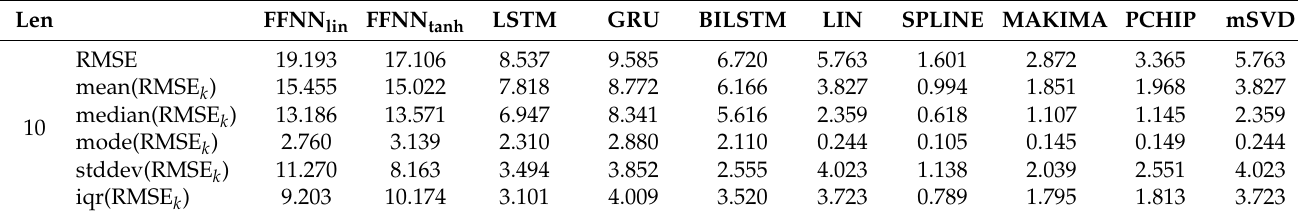
Table A5. Quality measures for the falling (No. 6)